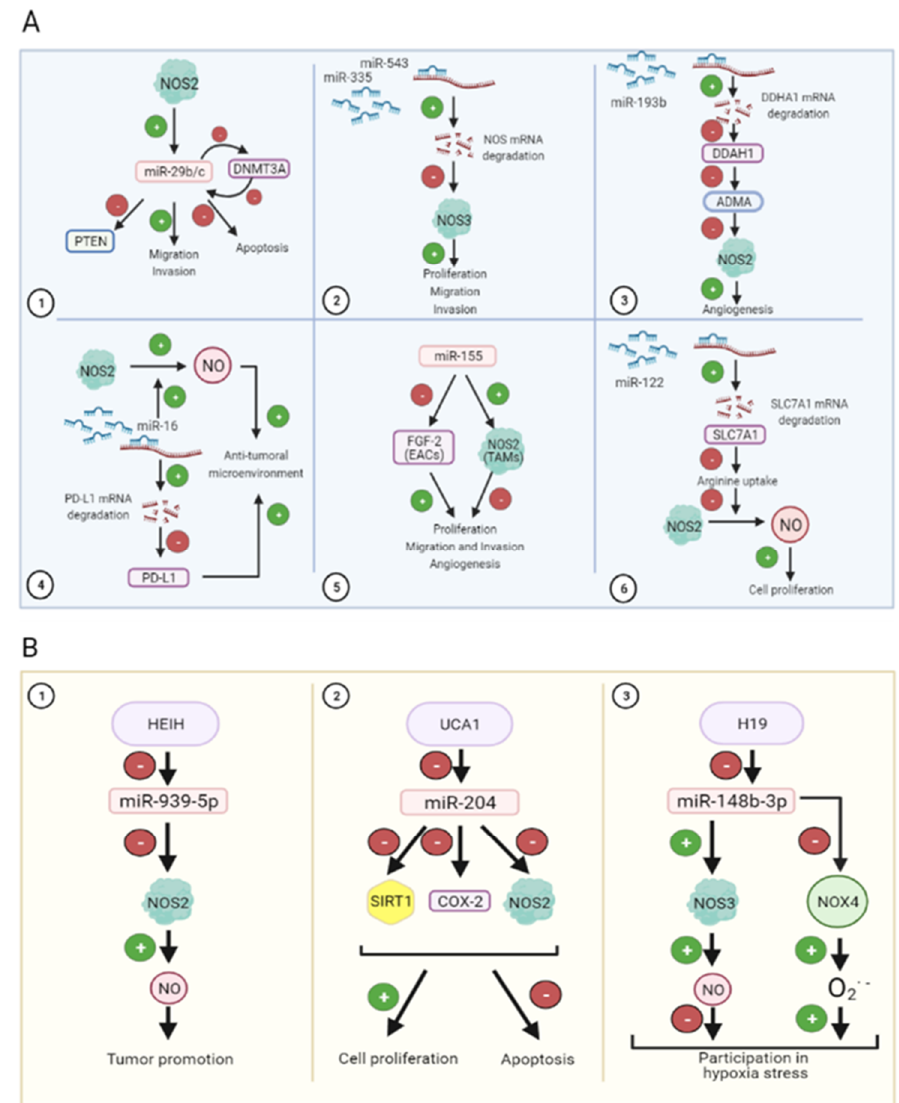
Figure 3. Implications of micro RNAs ( A ) and long non-coding RNAs ( B ) in carcinogenesis induced by NO. Inducible NOS (NOS2) positively regulates migration and invasion in cancer cells and negatively regulates phosphatase and tensin homolog (PTEN) suppressor gene and apoptosis through microRNA miR-29b/c expression induction. Furthermore, miR- 29b/c represses DNA demethylase DNMT3A in a negative feedback loop ( A1 ). Endothelial NOS (NOS3) also promotes